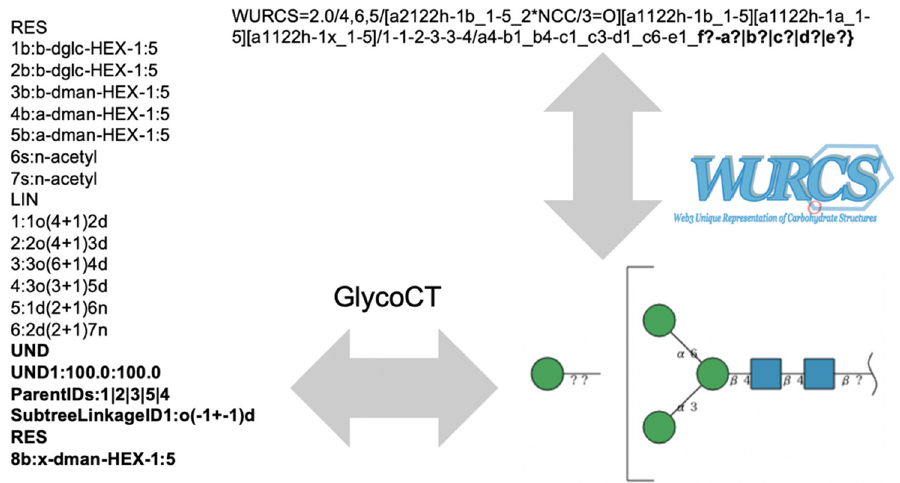
Figure 6. GlycoCT and WURCS containing fragment parts. The fragment parts of each format are indicated in bold.